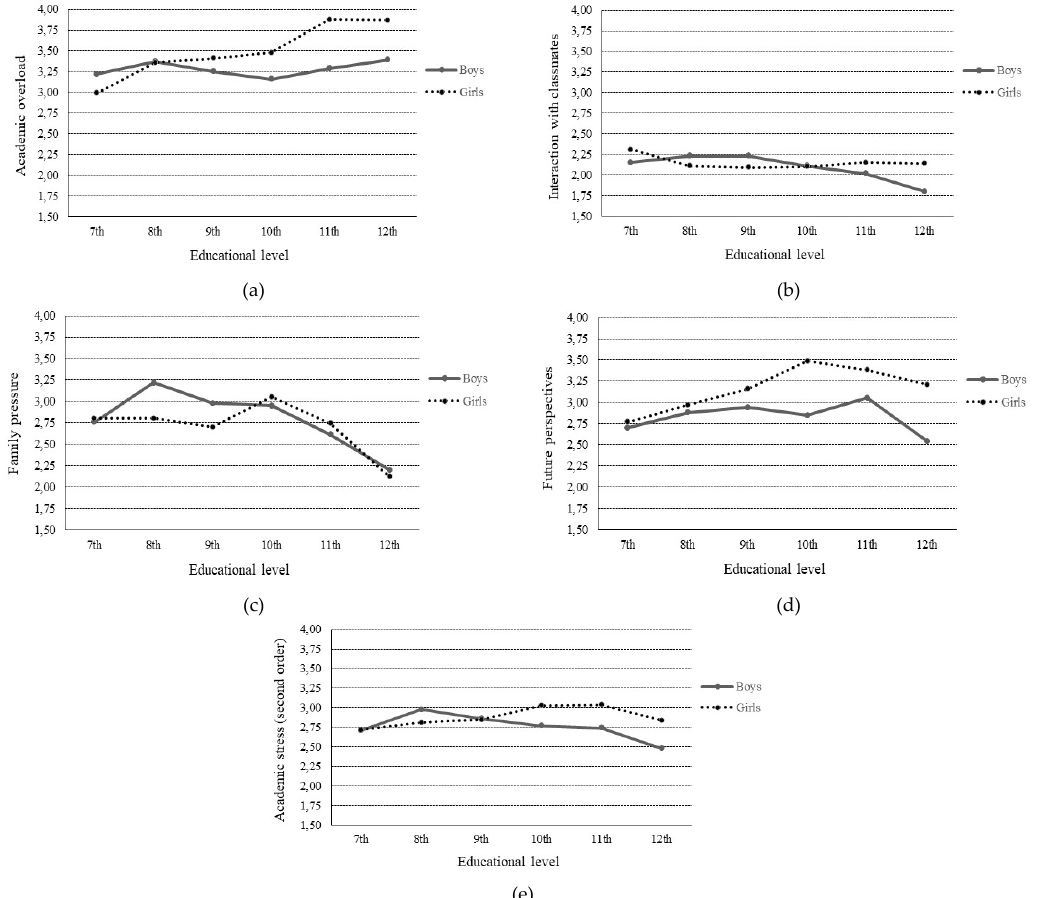
Figure 3. Mean scores on QASSE dimensions by gender and educational level: (a) Academic overload; (b) Interactions with classmates; (c) Family pressure; (d) Future perspectives; (e) Academic stress second order factor.